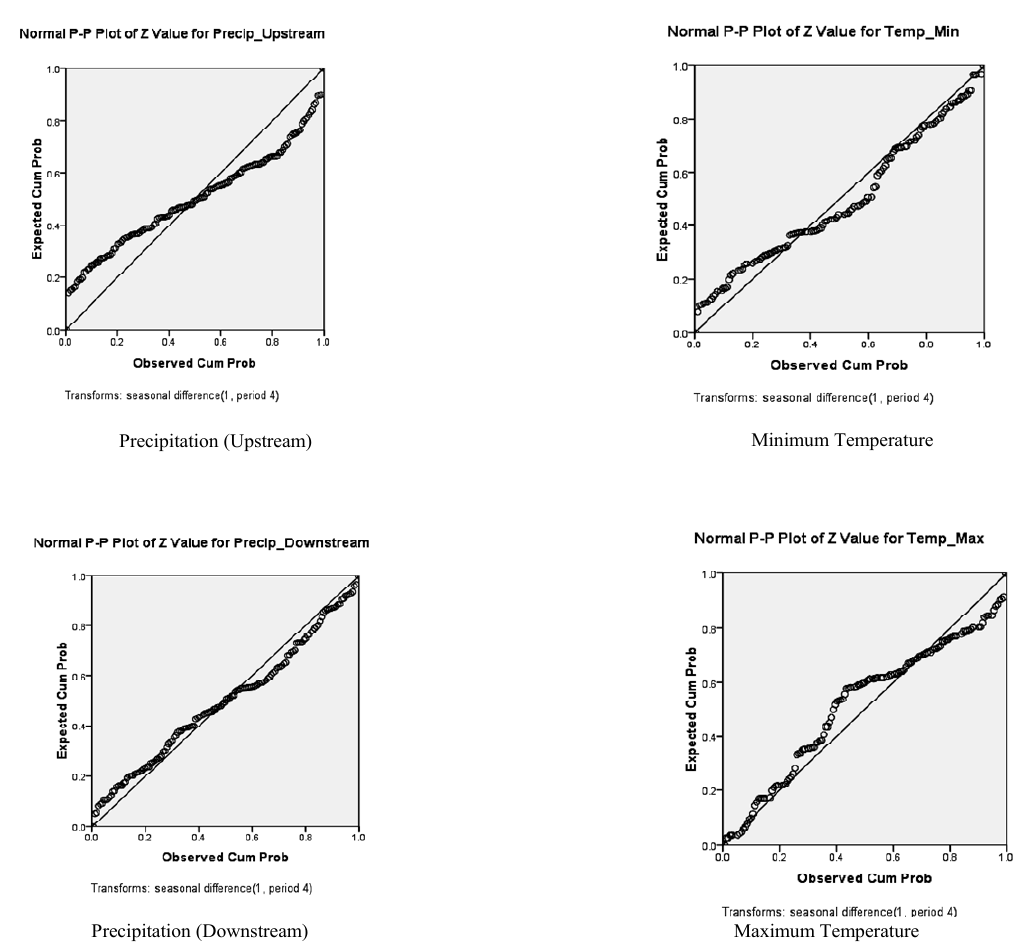
Figure 5. PP-plots for climatic trendshift in Muooni catchment (1971–2010 vs. 2011–2030). Transforms: Seasonal difference (1, period 4). Expected Cum Prob = Expected cumulative probability; Observed Cum Prob = Observed cumulative probability.